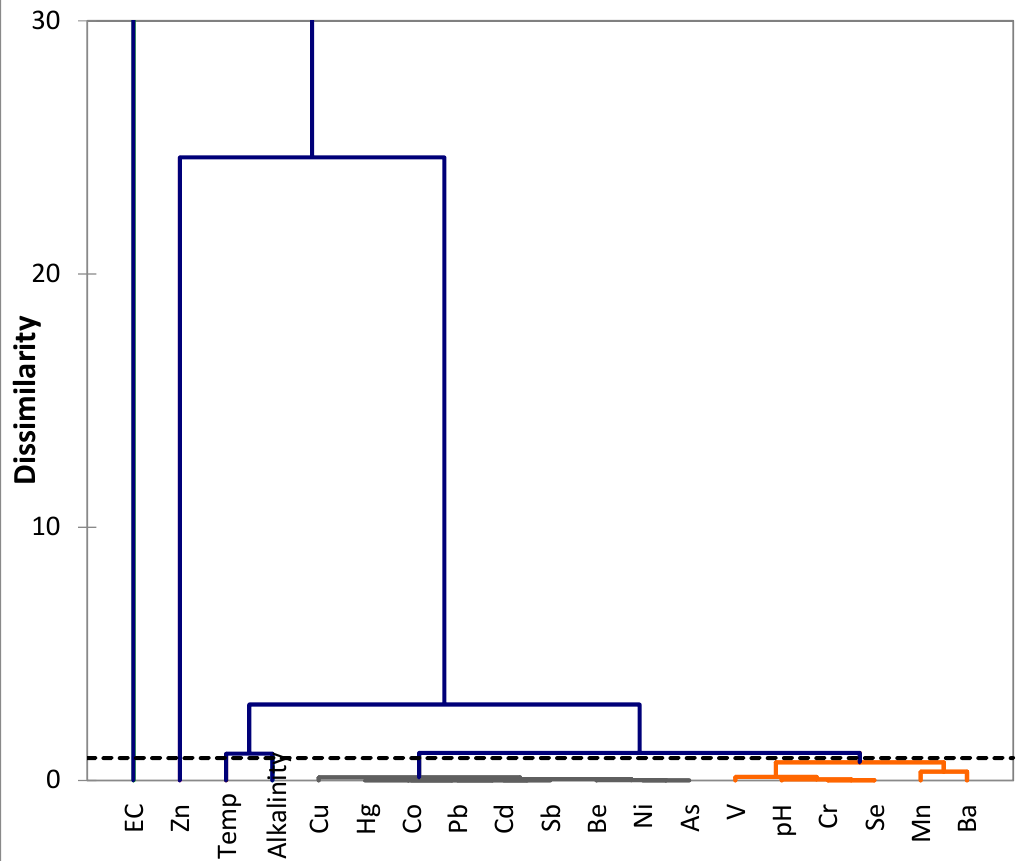
Figure 4. Dendrogram showing the spatial clustering of trace metals in geothermal spring/borehole water samples, based on the hierarchical cluster analysis using Ward’s method.